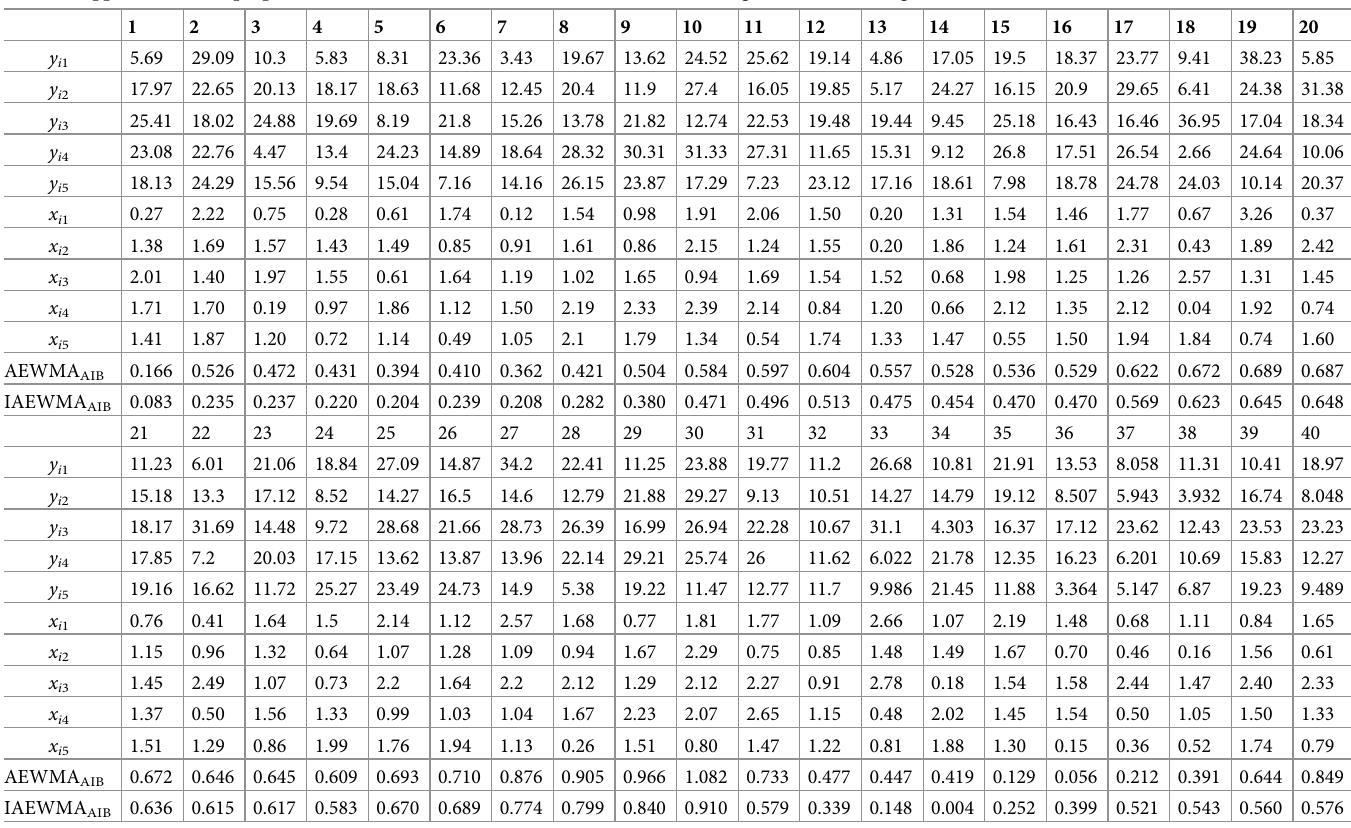
Table 7. Application of the proposed IAEWMA AIB versus AEWMA AIB control charts for glass manufacturing data.